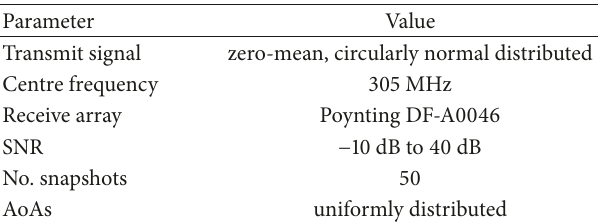
Figure 3: Normalised sensor positions in the x-y-plane (array top view) as assumed by the model, and before and after global calibration. The sensor positions are normalised to the centre wavelength 𝜆 푐 . Table 3: Parameters of the